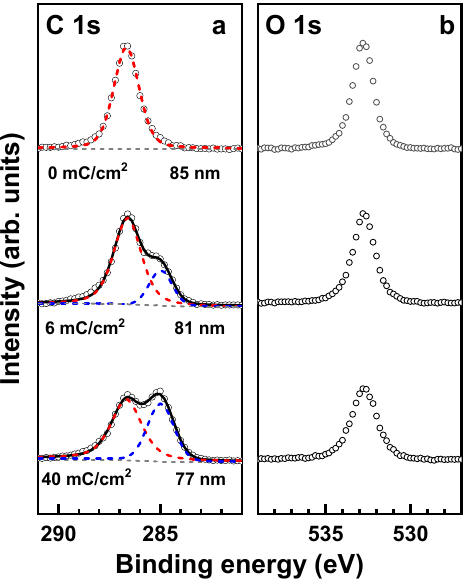
Figure 7. C 1s ( a ) and O 1s ( b ) XP spectra of the pristine and irradiated PEG films (open circles). The dose and thickness are given in the respective spectra. The C 1s spectra are decomposed into the components related to the pristine (red dashed line) and modified (blue dashed line) ether groups in the PEG film. The sum of these components for the irradiated films is drawn by the black solid line.